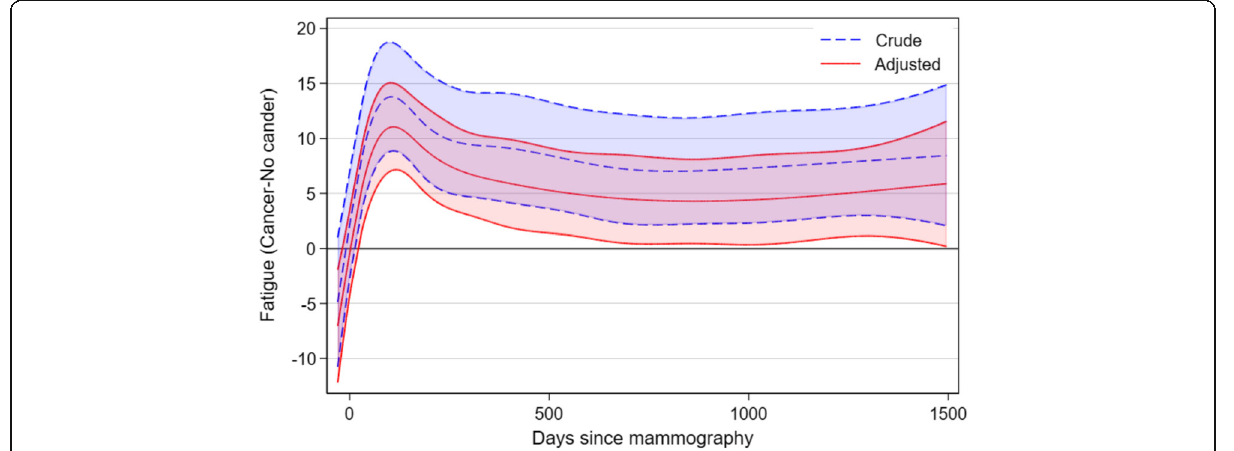
Fig. 4 Change in fatigue comparing women with breast cancer to women without breast